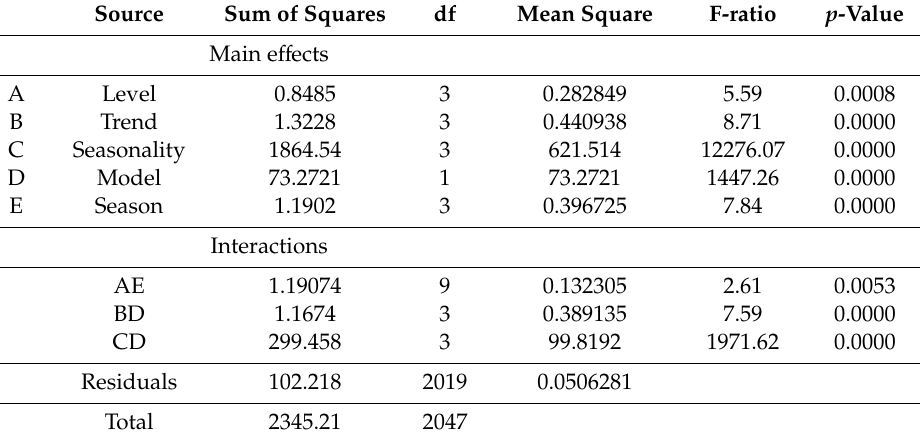
Table 6. Analysis of the variance for the factors studied using the models with additive trend, without adjustment.